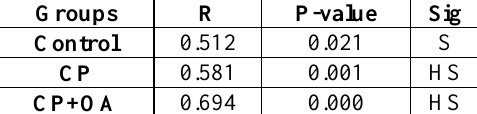
Table 5: Illustrates the correlation of TNFα and hsCRP among study